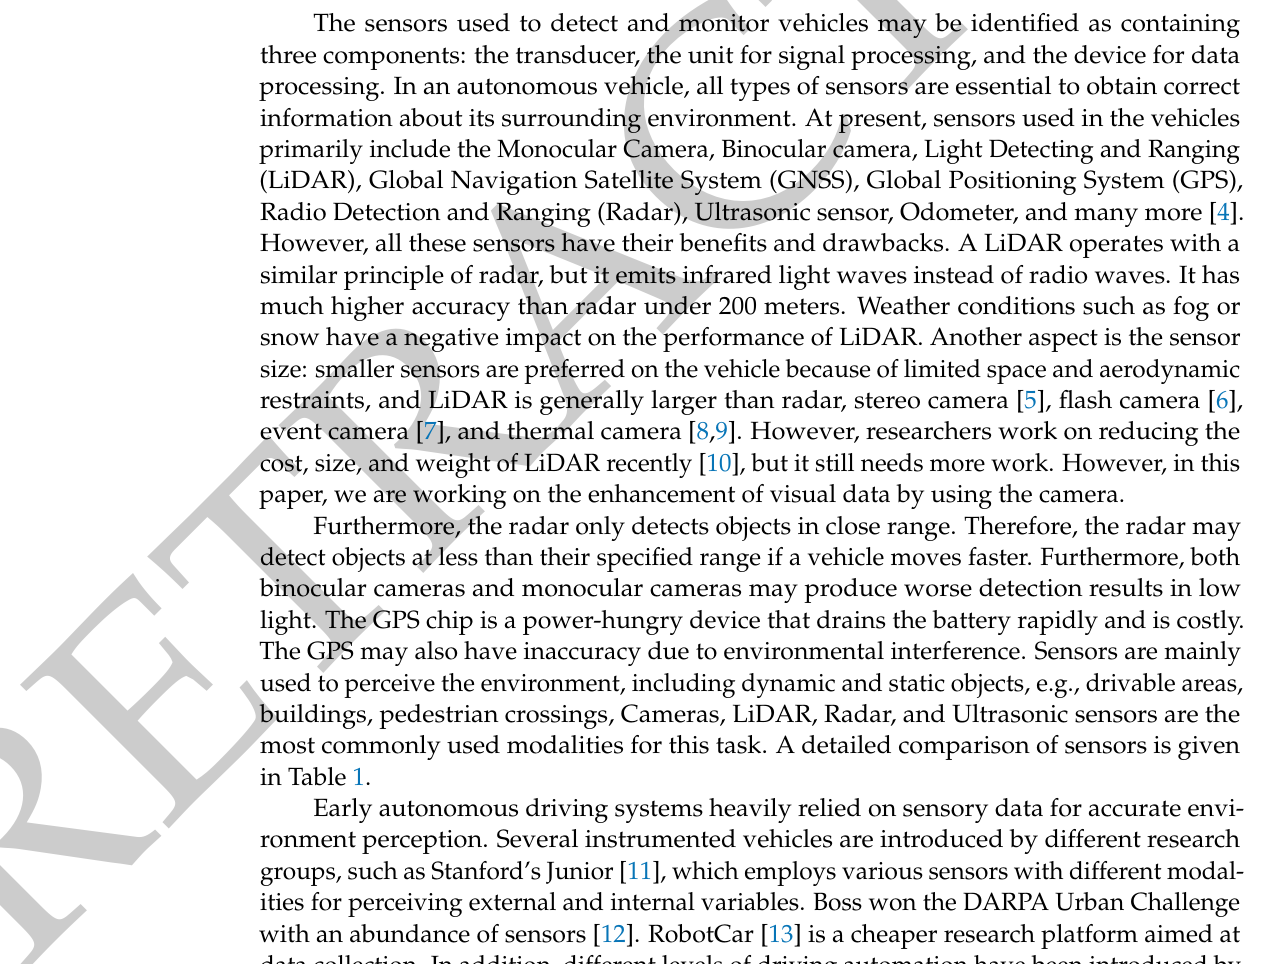
Figure 1. ( left ) Objects before detection; ( right ) Objects after detection show the detected object’s bounding box coordinates with the predicted confidence score and class label.